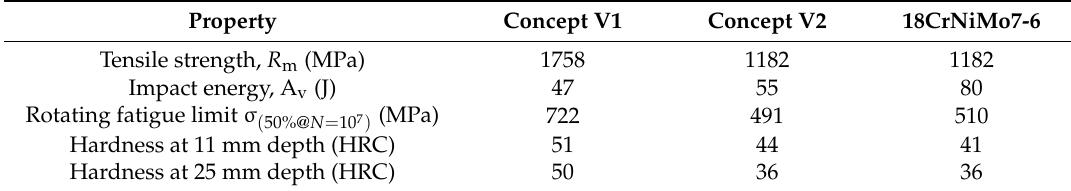
Table 3. Mechanical properties of developed case carburizing steels (hardened at 880 ◦ C/2 h + oil/180 ◦ C/2 h).